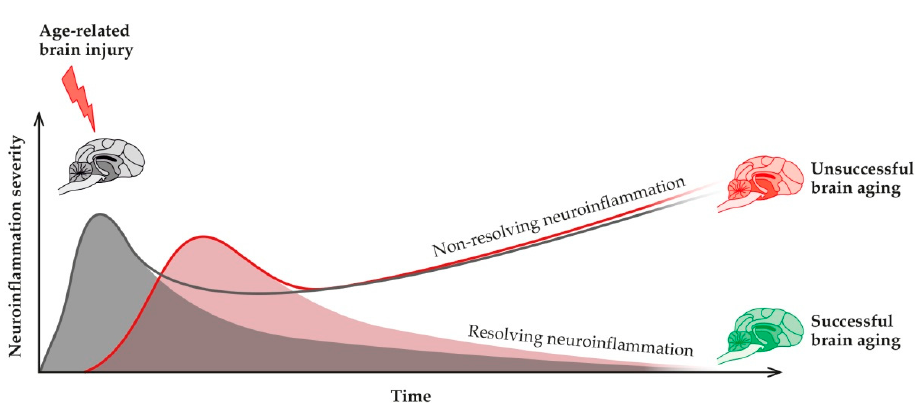
Figure 3. Neuroinflammation (red curve) is the physiological reparative response to age-related micro-injuries to the brain (grey curve). If the response is not correctly turned off, then non-resolving neuroinflammation might occur, with impaired adaptive brain responses, reduced resilience, and ultimately unsuccessful brain aging.